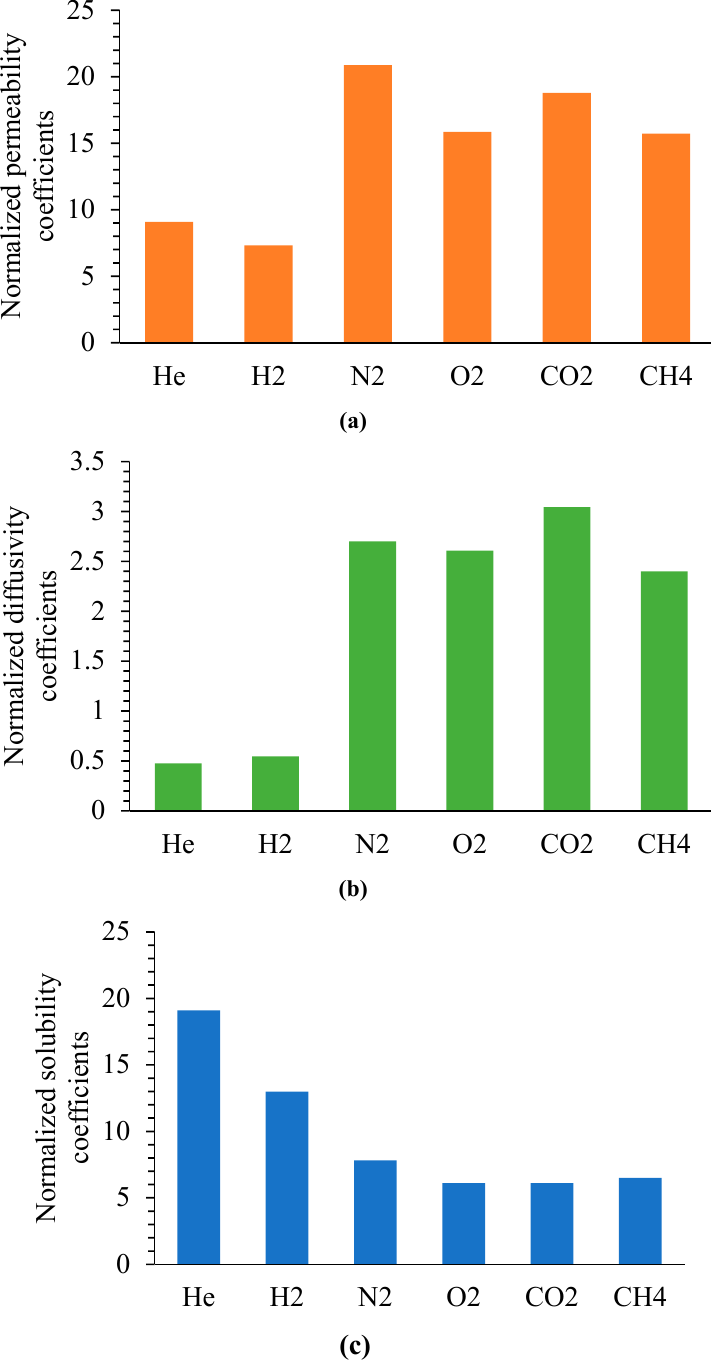
Figure 8. ( a ) Permeability coefficients of gases in APF5 normalized to the permeability coefficients of gases in MPF5; ( b ) diffusivity coefficients of gases in APF5 normalized to the diffusivity coefficients of gases in MPF5; ( c ) solubility coefficients of gases in APF5 normalized to the solubility coefficients of gases in MPF5.